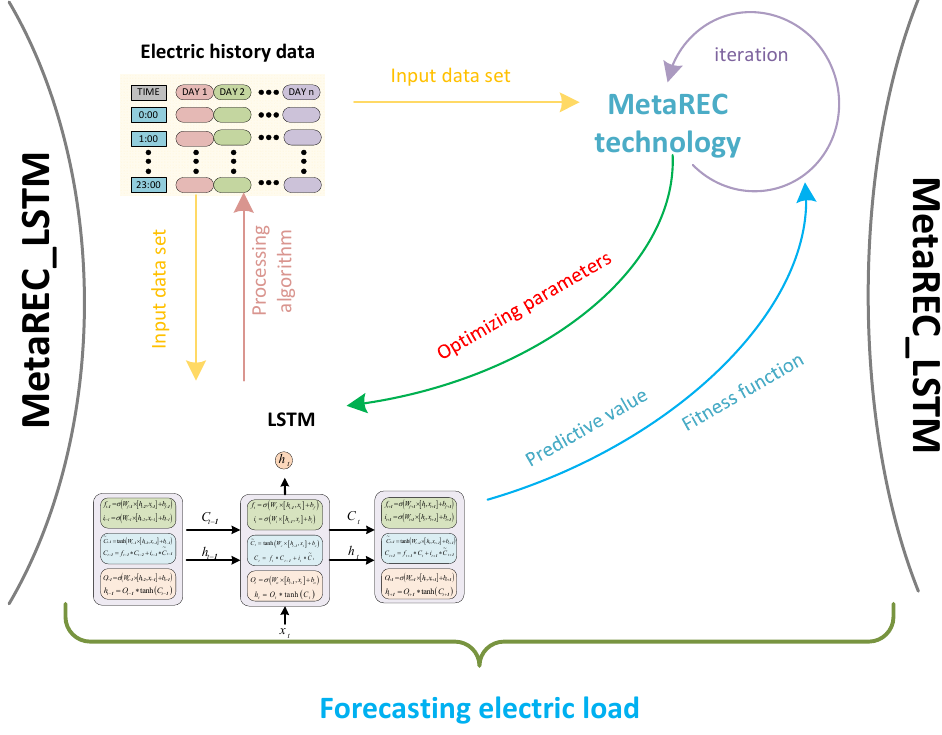
Figure 1. MetaREC_LSTM prediction framework for demand prediction with electricity manage- ment.